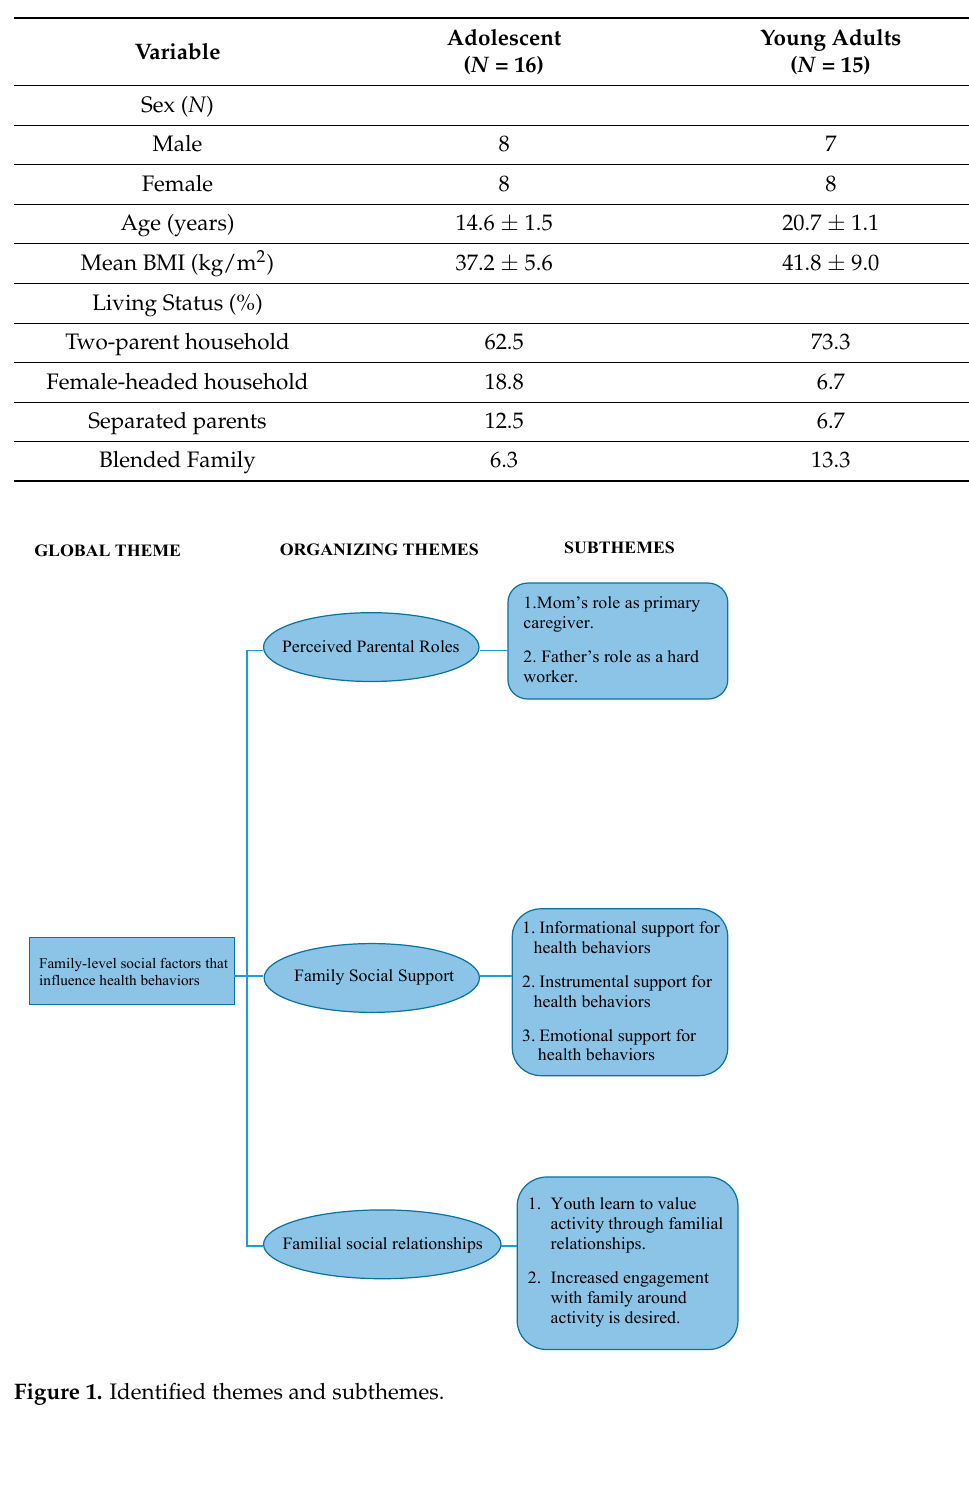
Table 2. Participant characteristics.